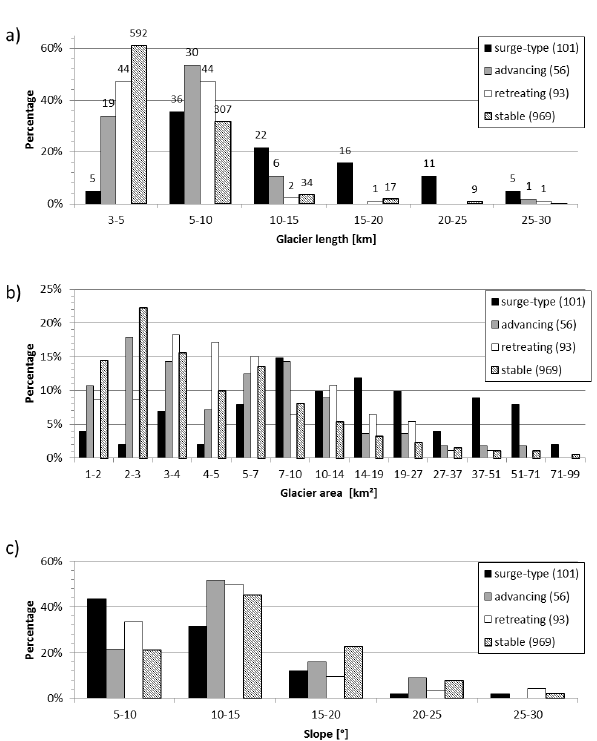
Figure 2. Percentage of glaciers classified as surge-type, advanc- ing, retreating, or stable during the observation period 1976–2012, related to the overall number of each class, divided into (a) glacier length, (b) catchment area, and (c) mean slope along the main glacier branch. The absolute numbers per glacier length class are given above the bars in panel (a)